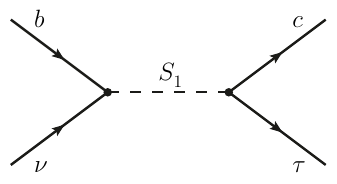
Figure 3 . The Feynman diagram for the tree-level contribution from S where the ratio m /g is constrained to be larger than 550 GeV by the neutrino trident Z 0 Z 0 process νN → νNµ + µ − [114]. Then it is not difficult to check that eq. (4.8) gives rise to 0 − 11 , which is much smaller than the observed value of ∆ a ∆ a Z µ ≈ 15 × 10 0 S reasonable to omit ∆ a Z 1 µ as the main contribution to ∆ a µ and regard ∆ a The effective Lagrangian related to the charged-current process b → cτν can